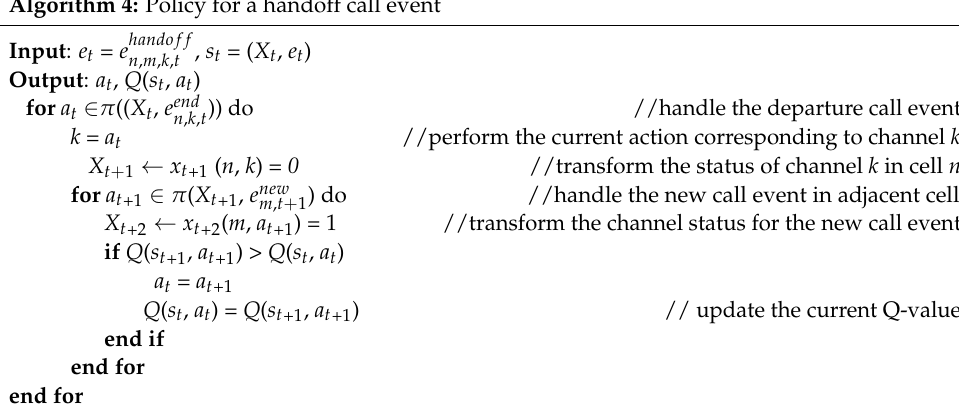
Figure 2. Reallocation for a handoff call event. ( a ) The handoff call occurs; ( b ) option 1: no reallocation; ( c ) option 2: reallocate to the call on ch3 ; ( d ) option 3: reallocate to the call on ch4 . Algorithm 4: Policy for a handoff call